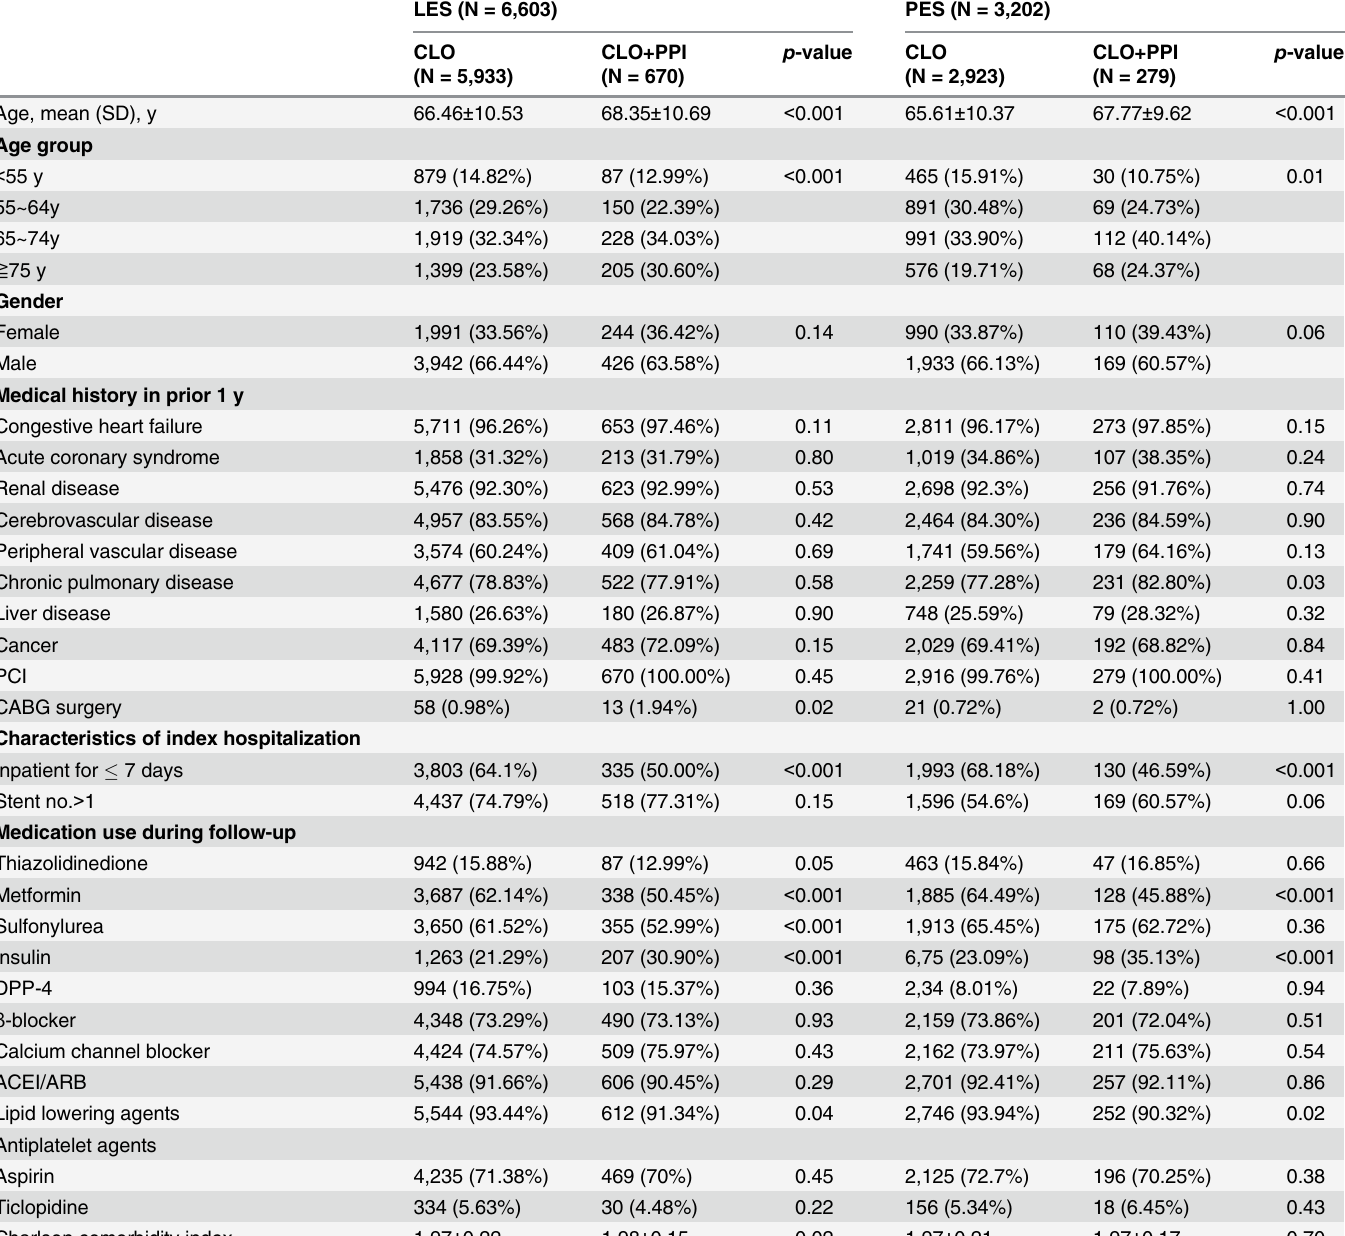
Table 1. Characteristics of diabetes mellitus patients who had received DES implantation, stratified by medication taken within 3 months after DES